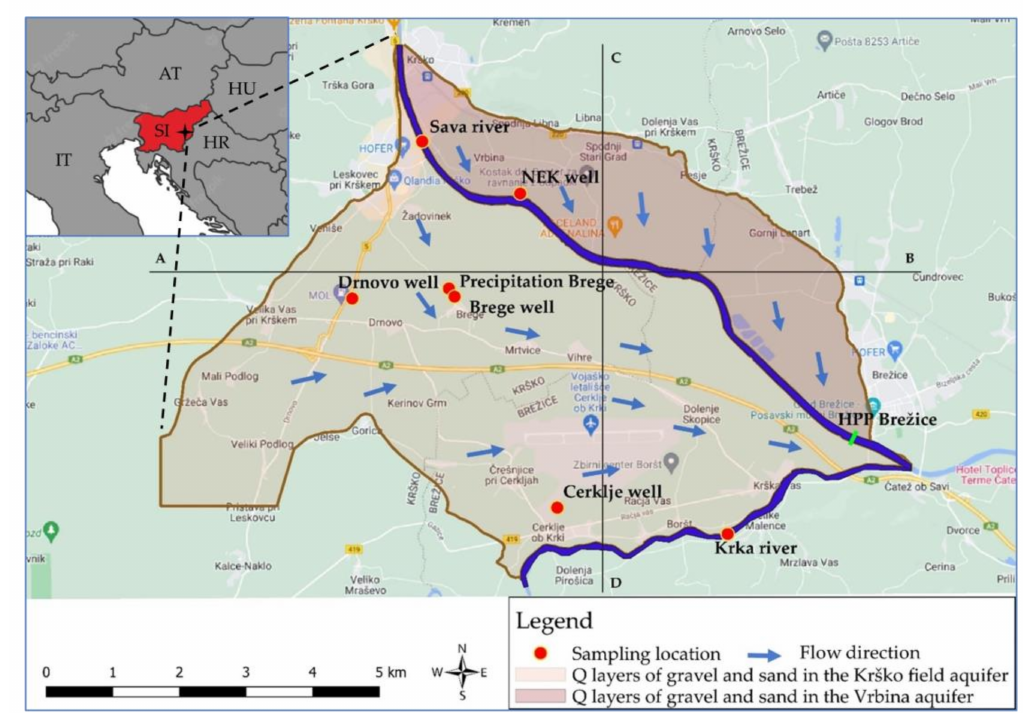
Figure 1. Field site with a simplified geological composition of the main groundwater flow directions (modified after [3]) and locations of water samples in relation to water